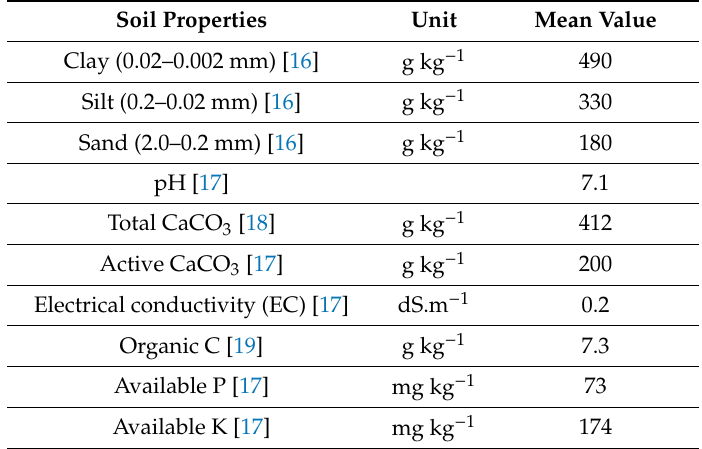
Table 1. Physicochemical properties of topsoil (0–40 cm) in Bourabia experimental